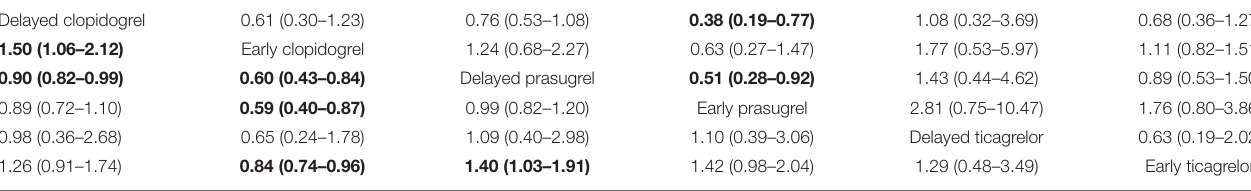
TABLE 2 | League table of the effects of P2Y 12 inhibitors expressed as hazard ratio with their 95% CIs on MACE (white cells) and bleeding (gray cells). Delayed clopidogrel